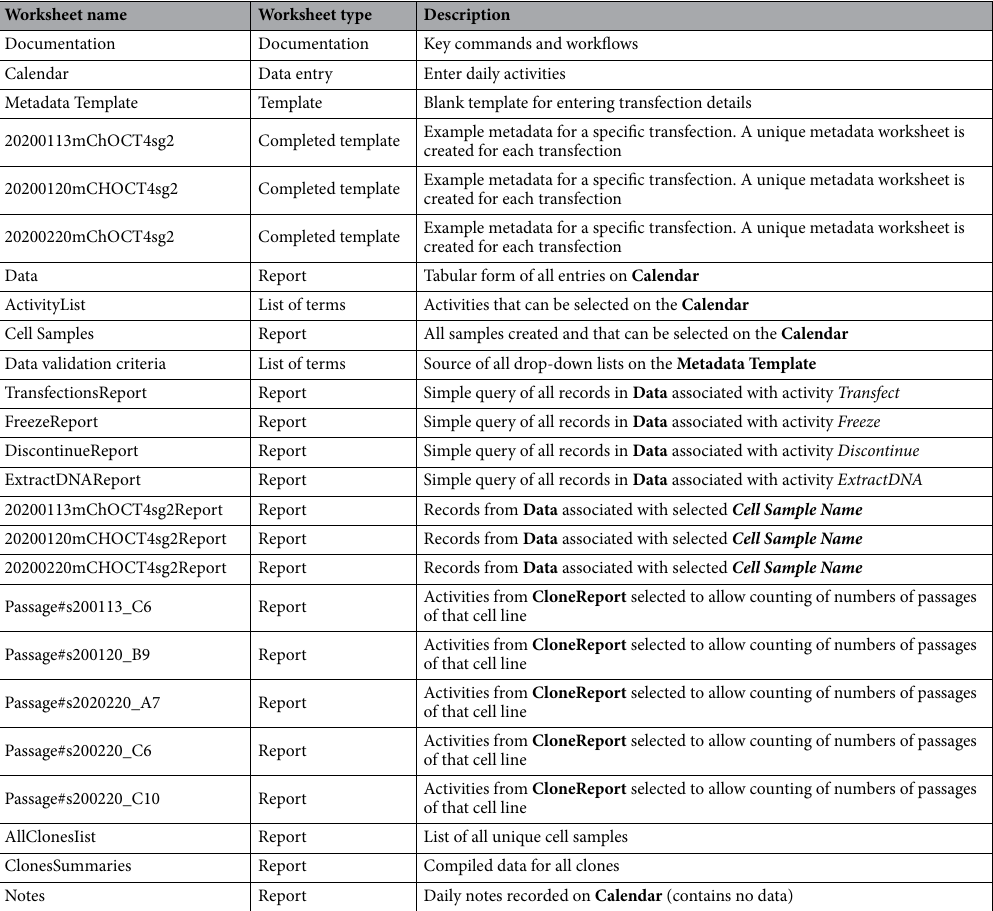
Table 2. Worksheets in TransfectionTracker1221.xlsm and their